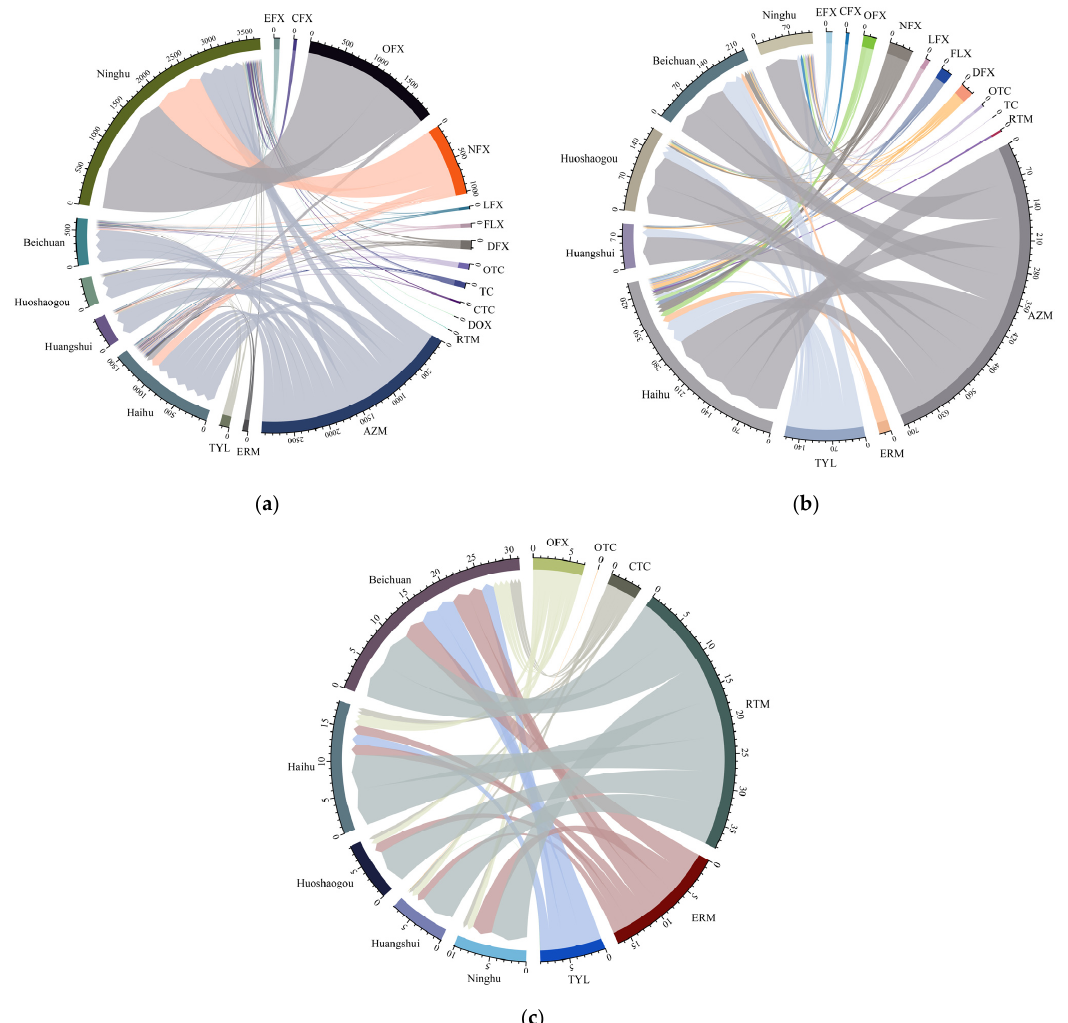
Figure 3. Composition of antibiotics at different wetlands in ( a ) water samples, ( b ) plant samples, and ( c ) sediment samples.